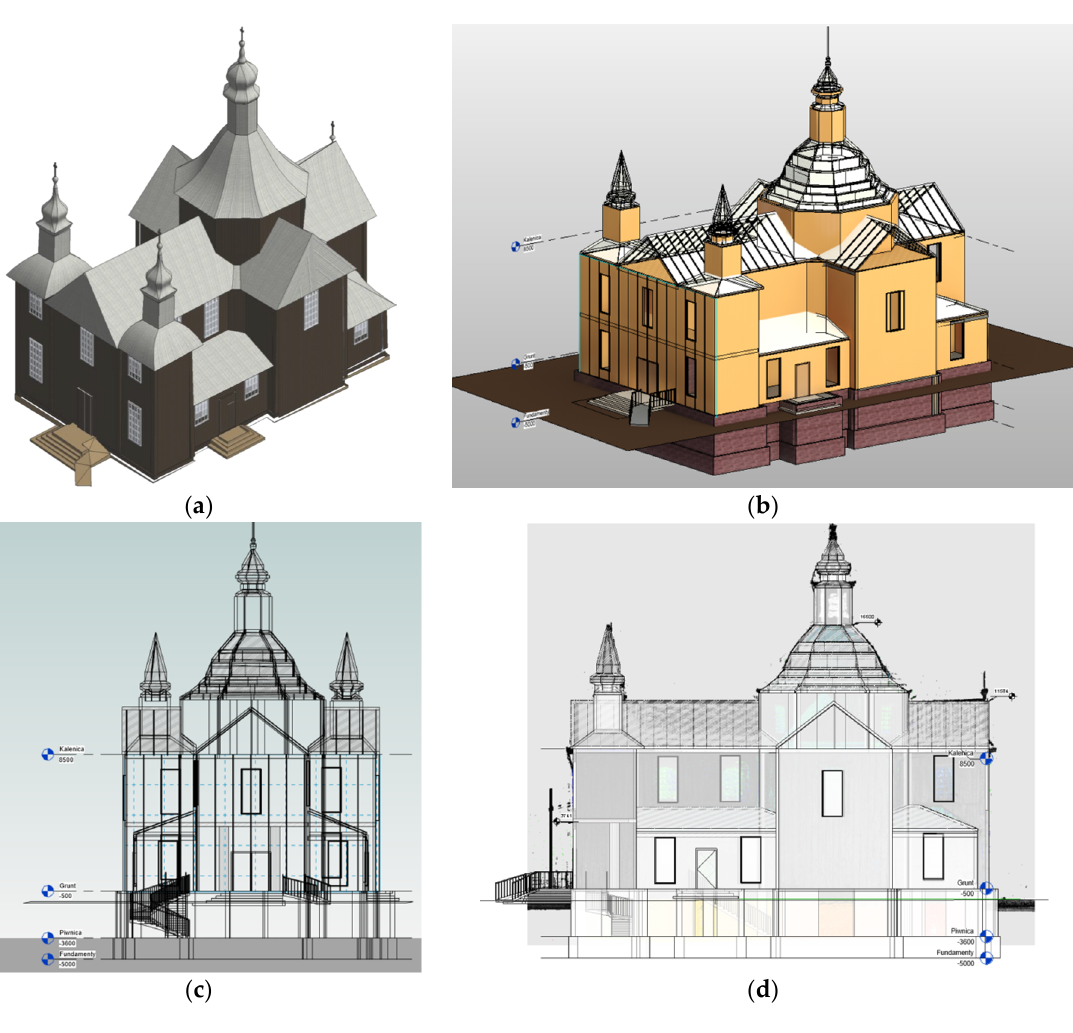
Figure 8. Model of the church St. Szczepan in Mnichów—southwest view (( a )—rendered model and ( b )—structural model) and construction projections (( c )—view from the entrance and ( d )—view from the south-west).